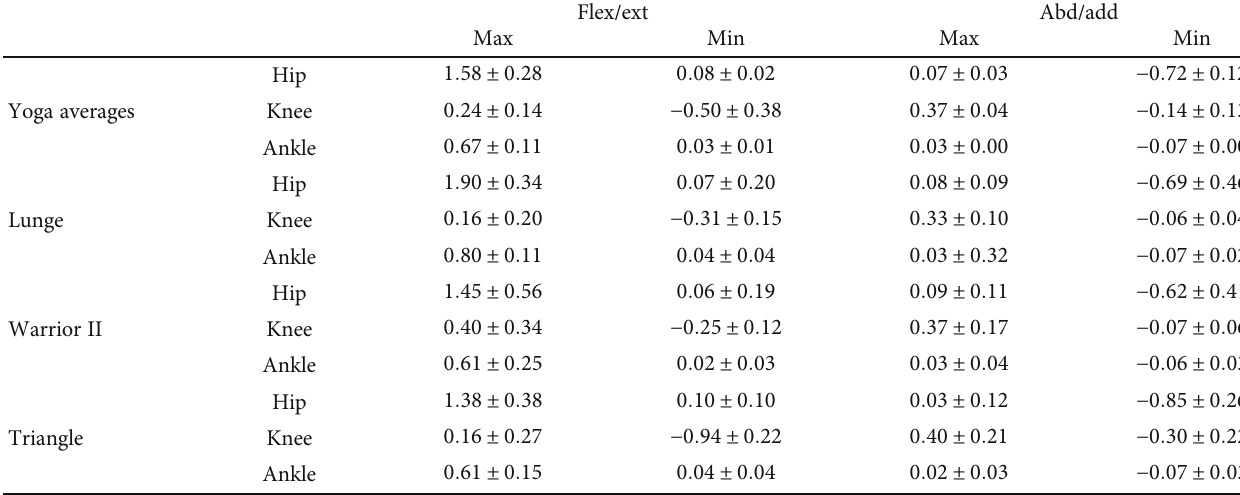
Table 2: Mean and standard deviation of bodyweight-normalised peak joint moments (Nm/kg) in the sagittal and frontal planes. Flex/ext